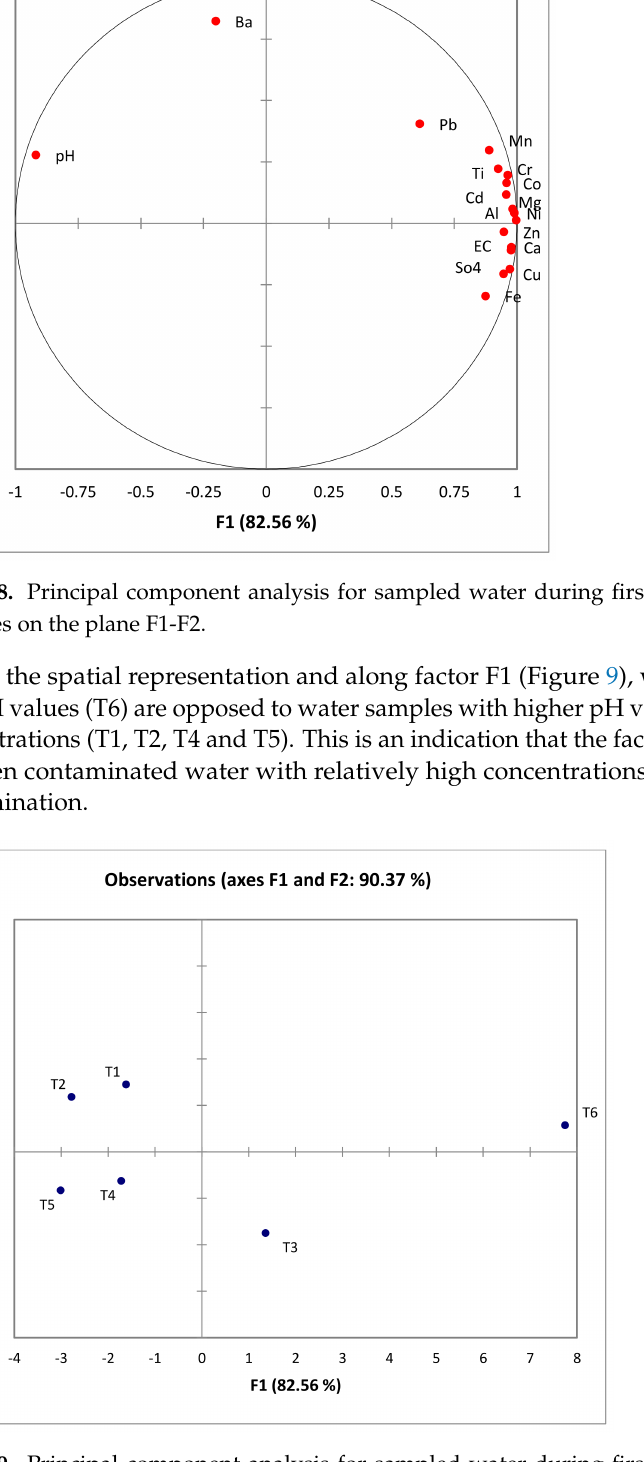
Figure 9. Principal component analysis for sampled water during first campaign: projection of individuals on the plane